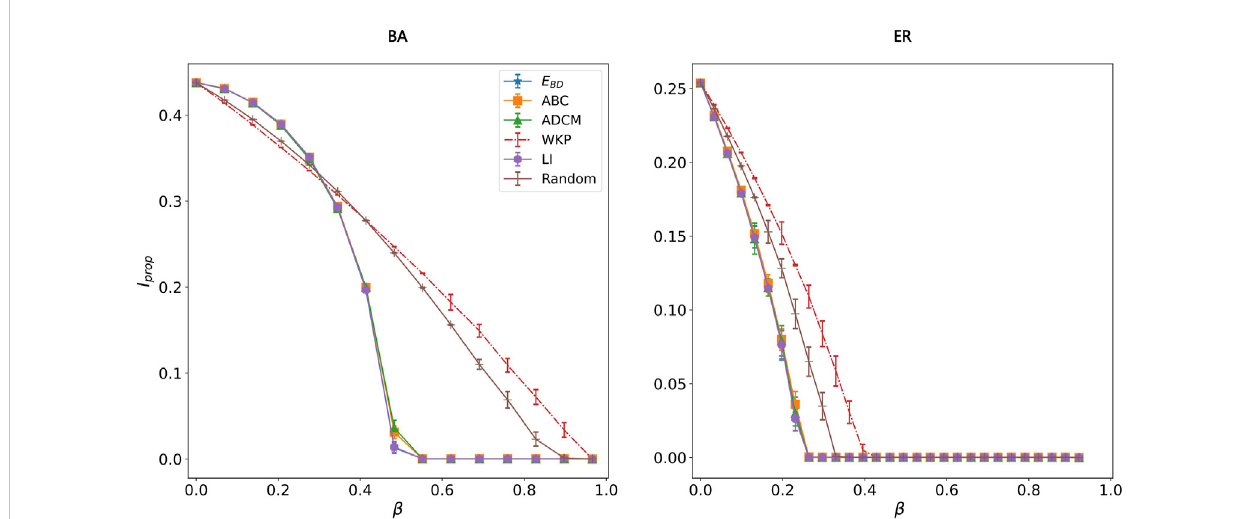
FIGURE 8 Performance comparison of our method E BD ( α =0.5) and the other methods in epidemic suppression. We show the spread range ( I prop ), as a function of the faction of removed edge ( β ) in two generated networks (BA network and ER network). For BA network, the number of nodes equals to 5,000 and the corresponding average degree is 6; as to ER network, the number of nodes is 5,000 and the average degree is 12. For both networks, the recovery probability γ is set to 0.5; the infectious probability μ is assigned to 0.2 and 0.06 for BA and ER networks, respectively.